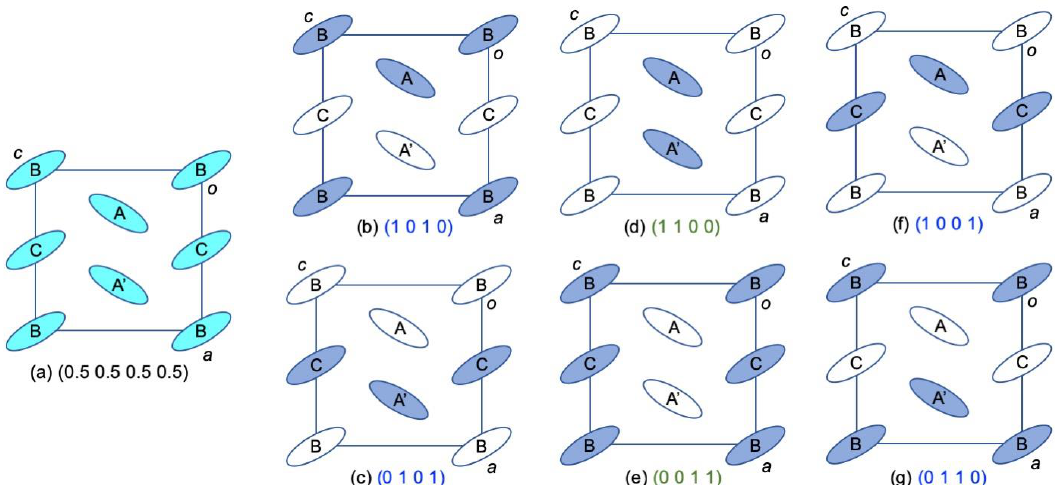
Figure 8. Schematic diagram of α -type packing arrangement of donor layer. ( b – g ) Schematics of the full set of six possible arrangements of neutral (white) and cationic (dark blue) donor molecules in the conduction plane, where ( w x y z ) means the molecular charges of A, A (cid:48) , B and C molecules (see Figure 3c) of w , x , y and z , respectively. Blue ( w x y z ) and green ( w x y z ) indicate that the charge-ordered patterns are horizontal and vertical stripes, respectively. The same colours are used in Table 3. ( a ) A schematic diagram of the non-charge-ordered state, where each molecule has a + 1 / 2 charge (light blue). Table 3. Madelung energies of α -(BEDT-TTF) 2 I 3 , α -(BETS) 2 I 3 and 3 .